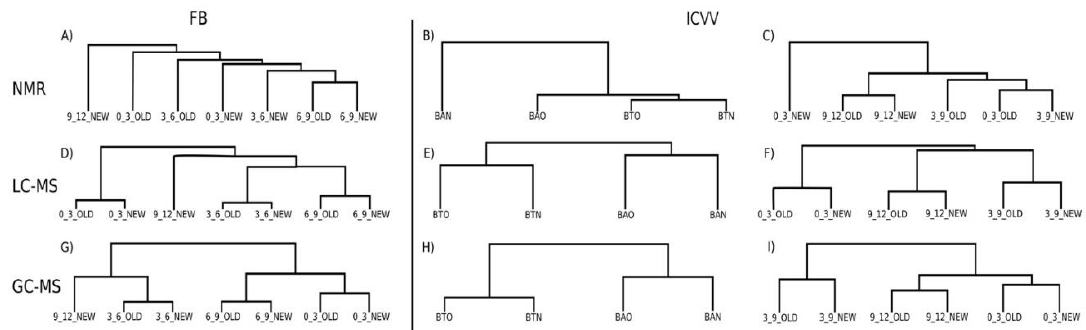
Figure 2. Growth rates hierarchical clustering of samples for region FB ( A , D , G ) and ICVV ( B , C , E , F , H , I ) based on different analytical methods. Acronyms BAN and BAO refer to 12th month barrel-aged wine from new and old barrel, respectively, and BTN and BTO to bottle-aged wine from new and old barrel, respectively. Samples containing the labels OLD and NEW refer to barrel-aged wine from old and new barrel, respectively, whereas numbers at the beginning of the labels represent growth rate periods.